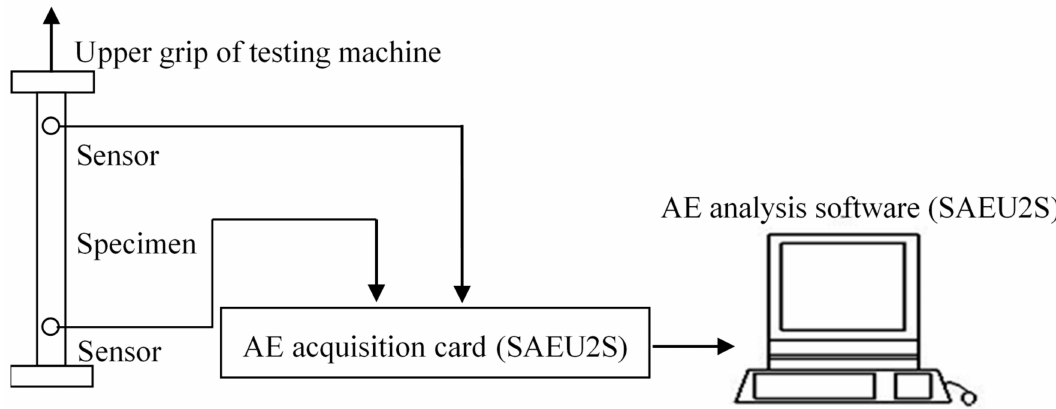
Figure 3. The tensile process of the 3D braided